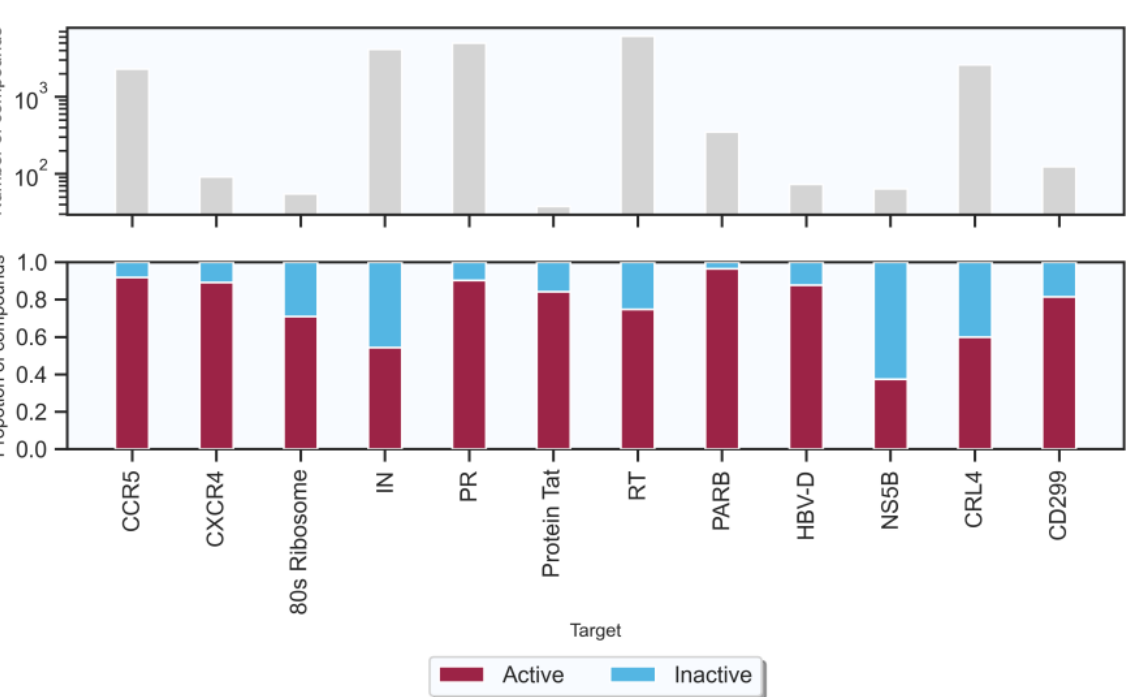
Figure 2. Size and composition of the target-associated compound data sets. The number of com- pounds in the upper panel is displayed on a logarithmic scale. Table 1. Detailed statistical analysis of the 15 data sets.